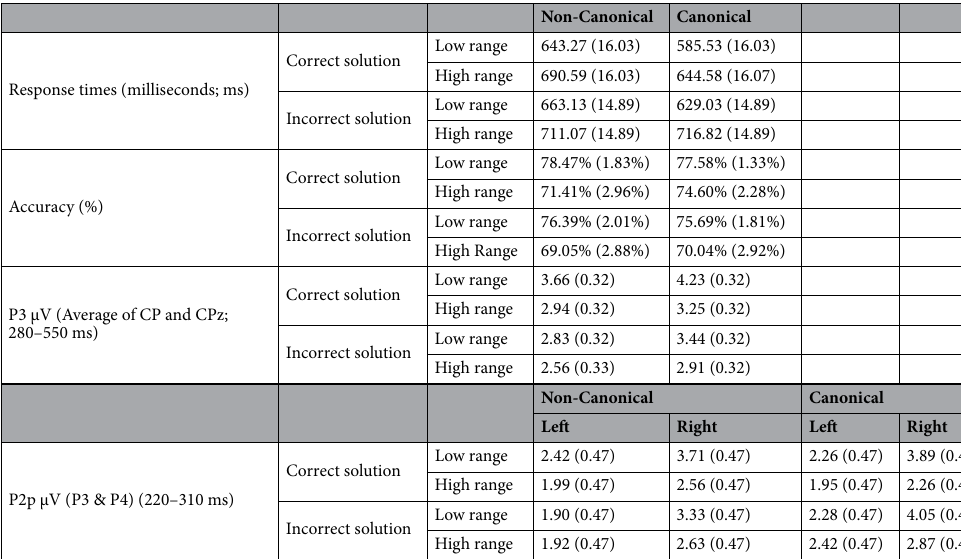
Table 1. Means and Standard Errors (between brackets) for behavioral and ERP data in the four Canonicity- Range conditions separated for Solution Correctness and hemisphere. Values shown are estimated marginal means with Standard Errors. | Low Range = average of 2, 3 and 4; High Range = average of 7, 8 and